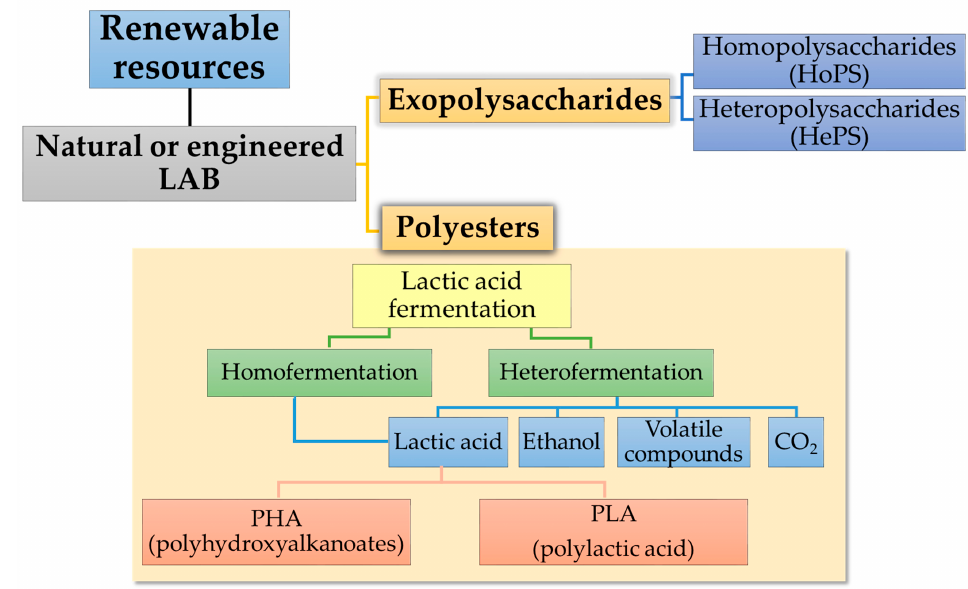
Figure 3. Polymers produced by lactic acid bacteria—general overview.